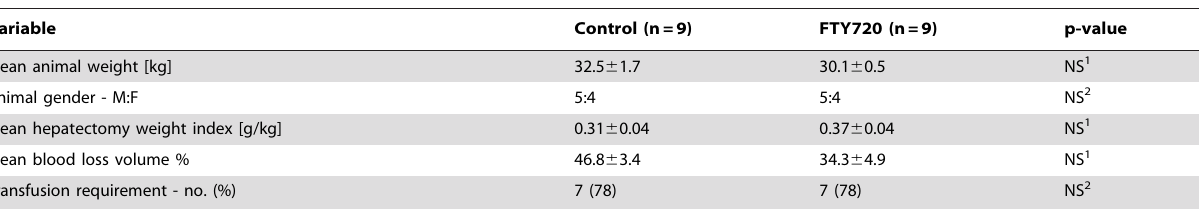
Table 2. Animal clinical